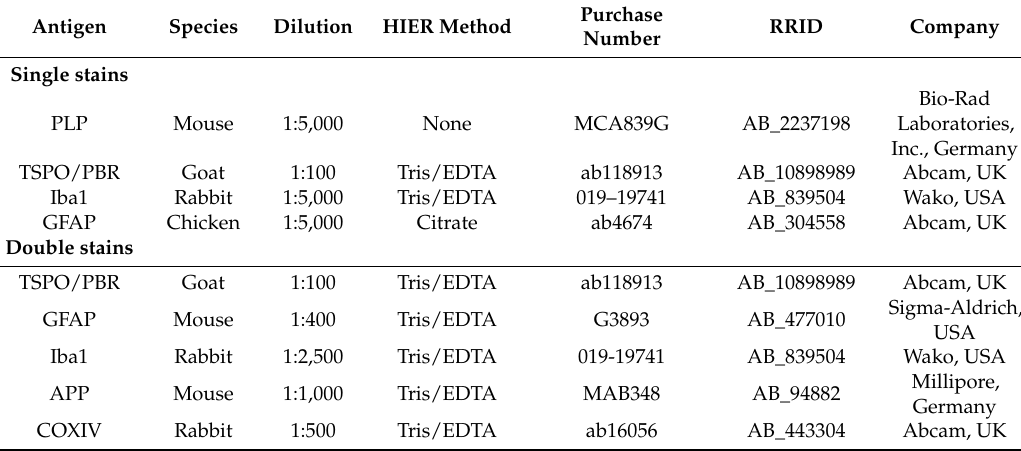
Table 2. List of the antibodies used in this